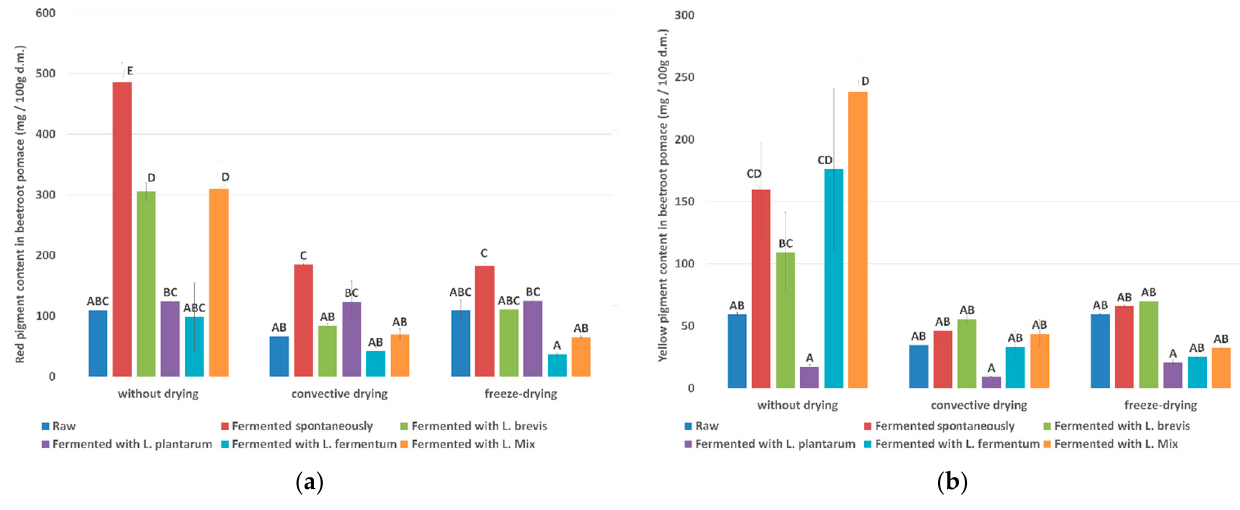
Figure 1. Pigment content in tested fermented beetroot pomace ( a ) Red pigment (betanin) content in beetroot pomace; ( b ) Yellow pigment content in fermented beetroot pomace. A, B…—different indexes for individual series mean statistically significant differences for given values at the level of p < 0.05.